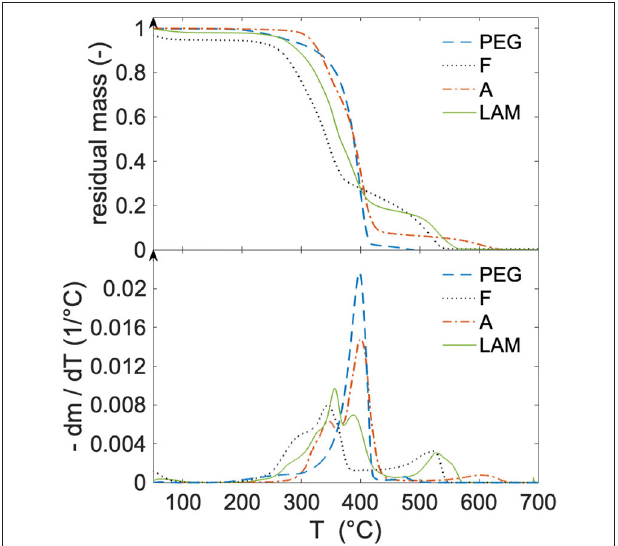
FIGURE 3 | Results of the TGA tests on the samples F, A, PEG, and LAM: residual mass and mass loss derivative as a function of temperature.